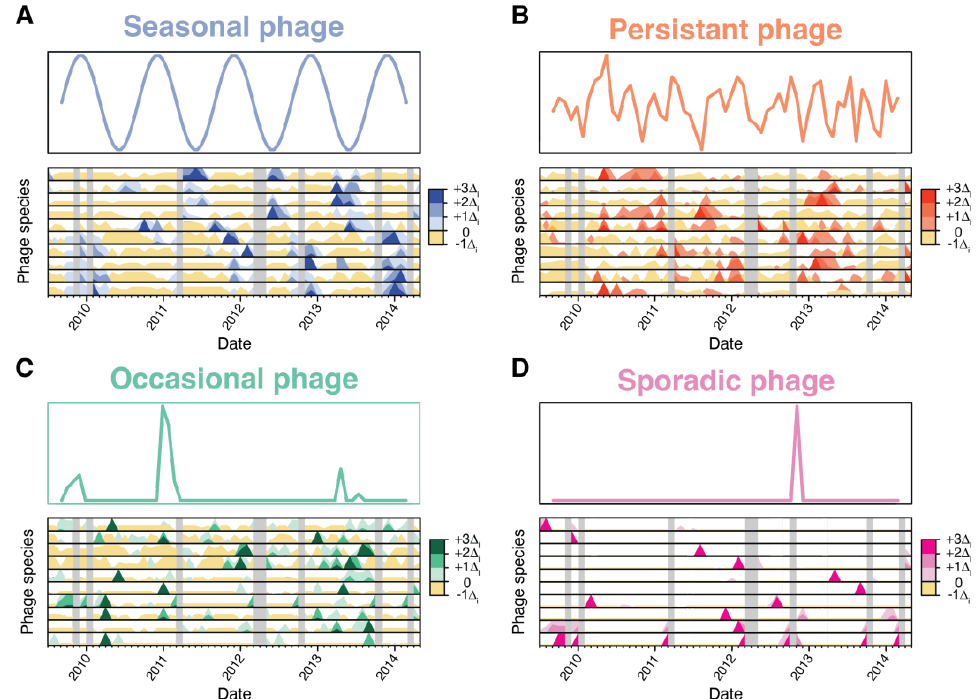
Figure 2. T4-like cyanophages belong to one of several dynamic classes. Horizon plots (lower plot in each panel) show select representative cyanophage species belonging to the ( A ) seasonal, ( B ) persistent, ( C ) occasional, and ( D ) sporadic dynamic categories (see text for descriptions). The top plot in each panel depicts idealized representations of the dynamics of each phage dynamic category. For horizon plots, the relative abundance of each phage species (one species per row) is centered around the mean abundance, with the intensity of color indicating changes in abundance by standard deviations above or below the mean. Gray vertical bars indicate months with missing data.